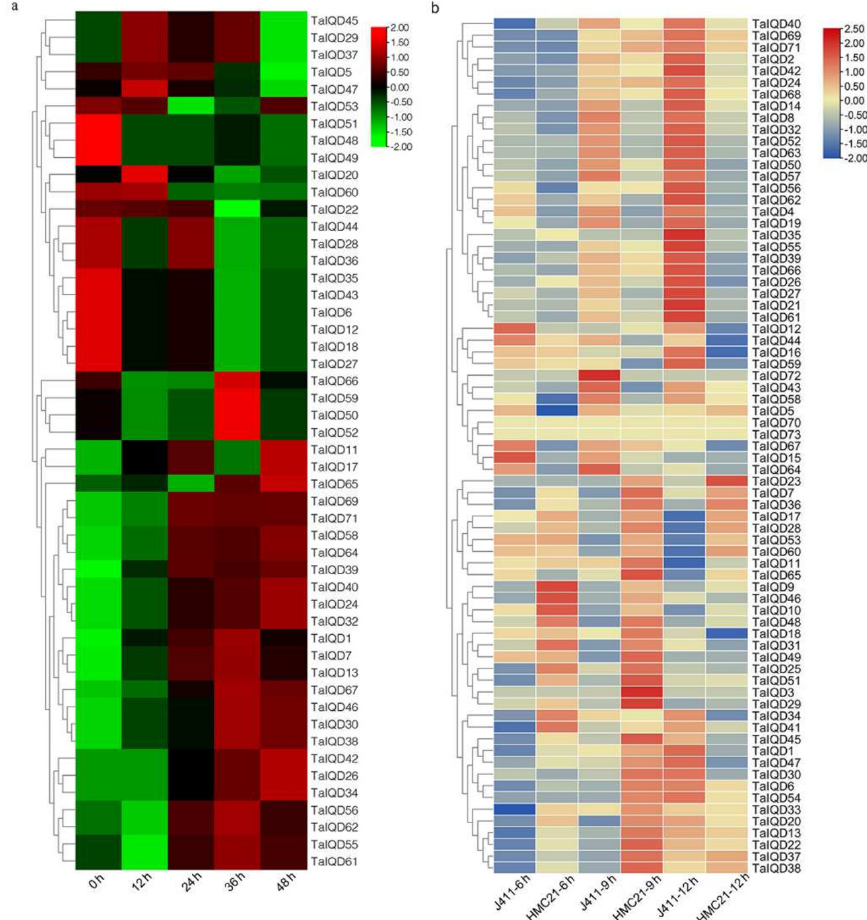
Figure 7. Heat map showing the hierarchical clustering of TaIQDs from different databases. ( a ) GSE49821. Abbreviations represent ‘Jimai20’ (JM20) germinating seed imbibition times: 0, 12, 24, 36, and 48 h. ( b ) Imbibition times of ‘Hongmangchun21’ (HMC21)- and ‘Jing411’ (J411)-germinated seeds: 6, 9, and 12